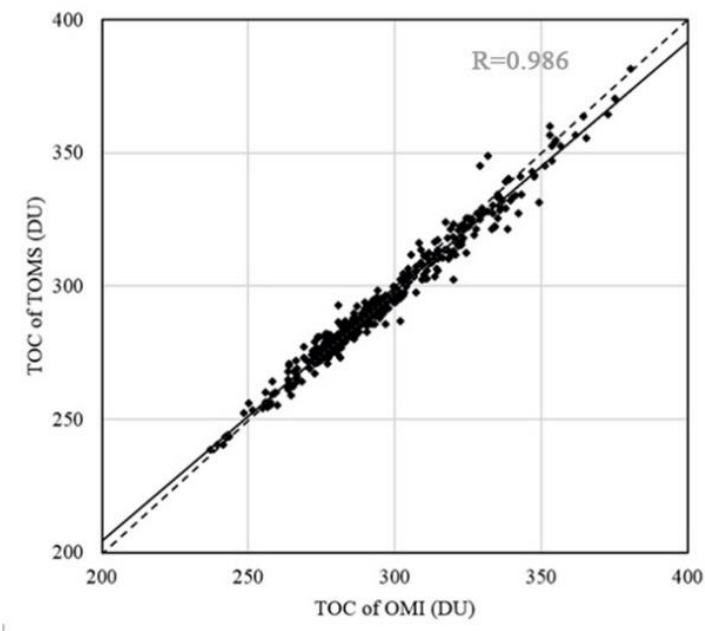
Figure 3. Relationship between the TOC data derived from TOMS and OMI from 1 October 2004 to 14 December 2005.